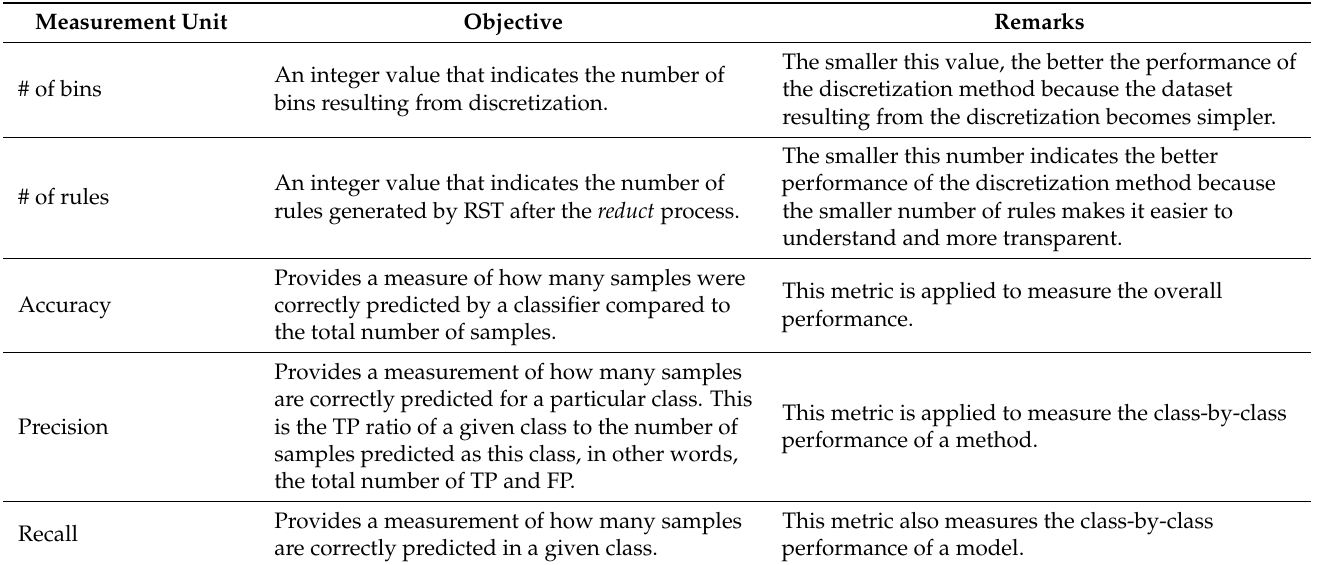
Table 2. Metrics to measure the